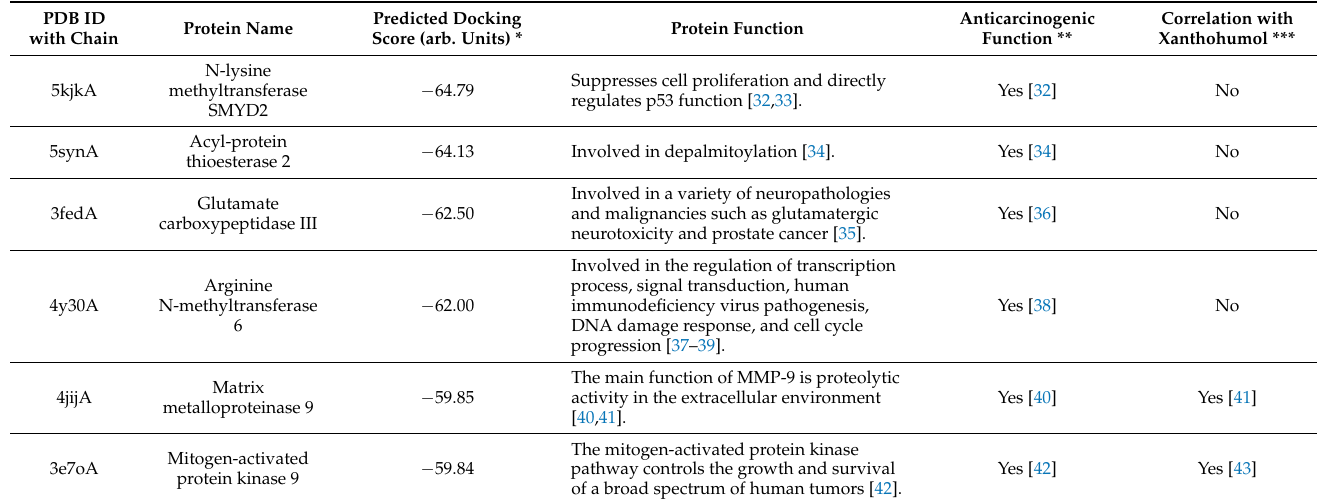
Table 1. Potential human protein targets of